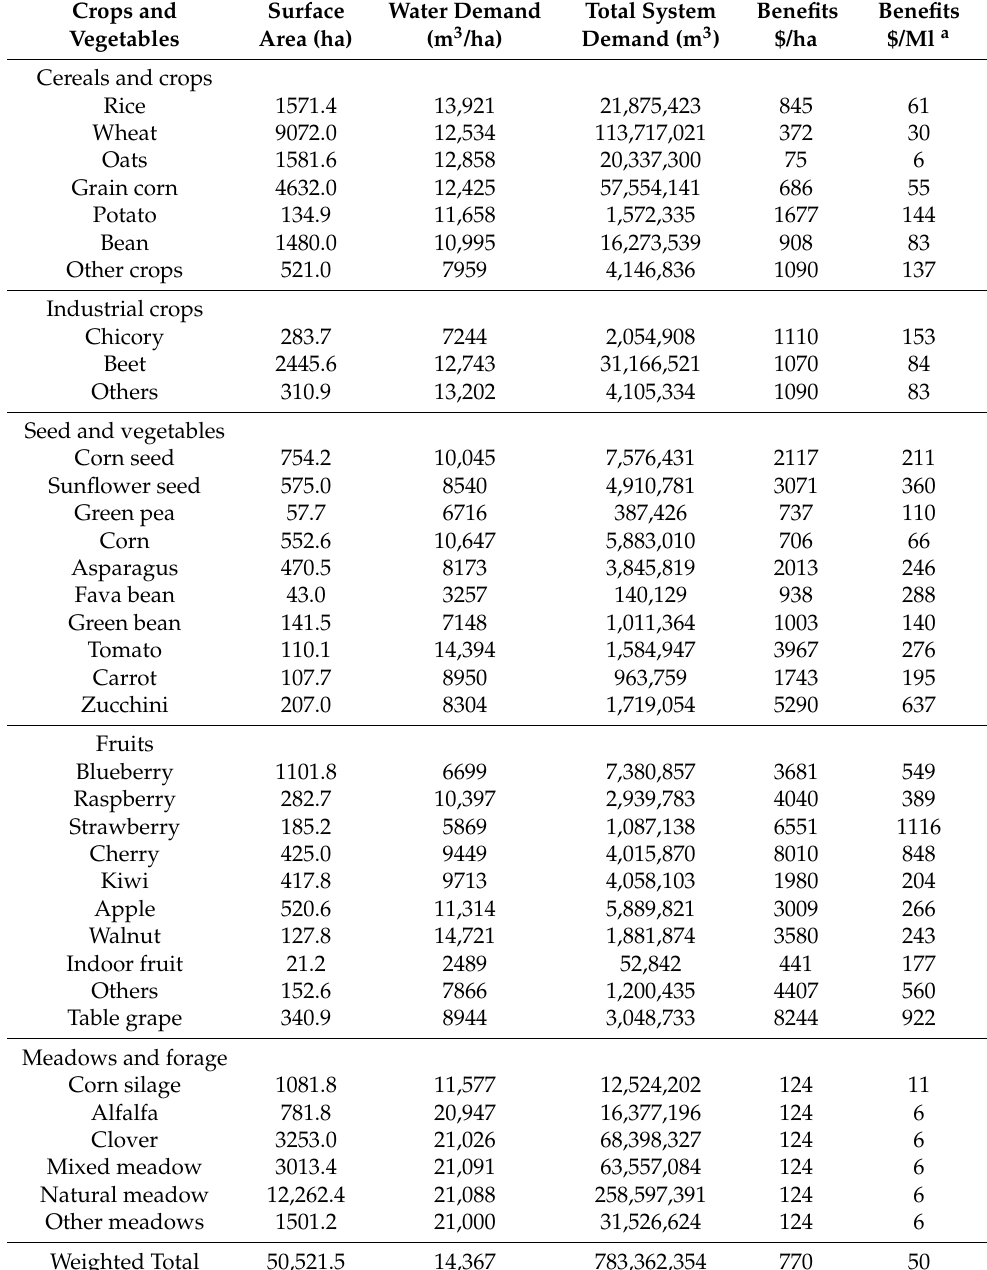
Table 1. ÑIRS hydro-economic model. Surface area, water demand, and profitability per crop type. Seasonal